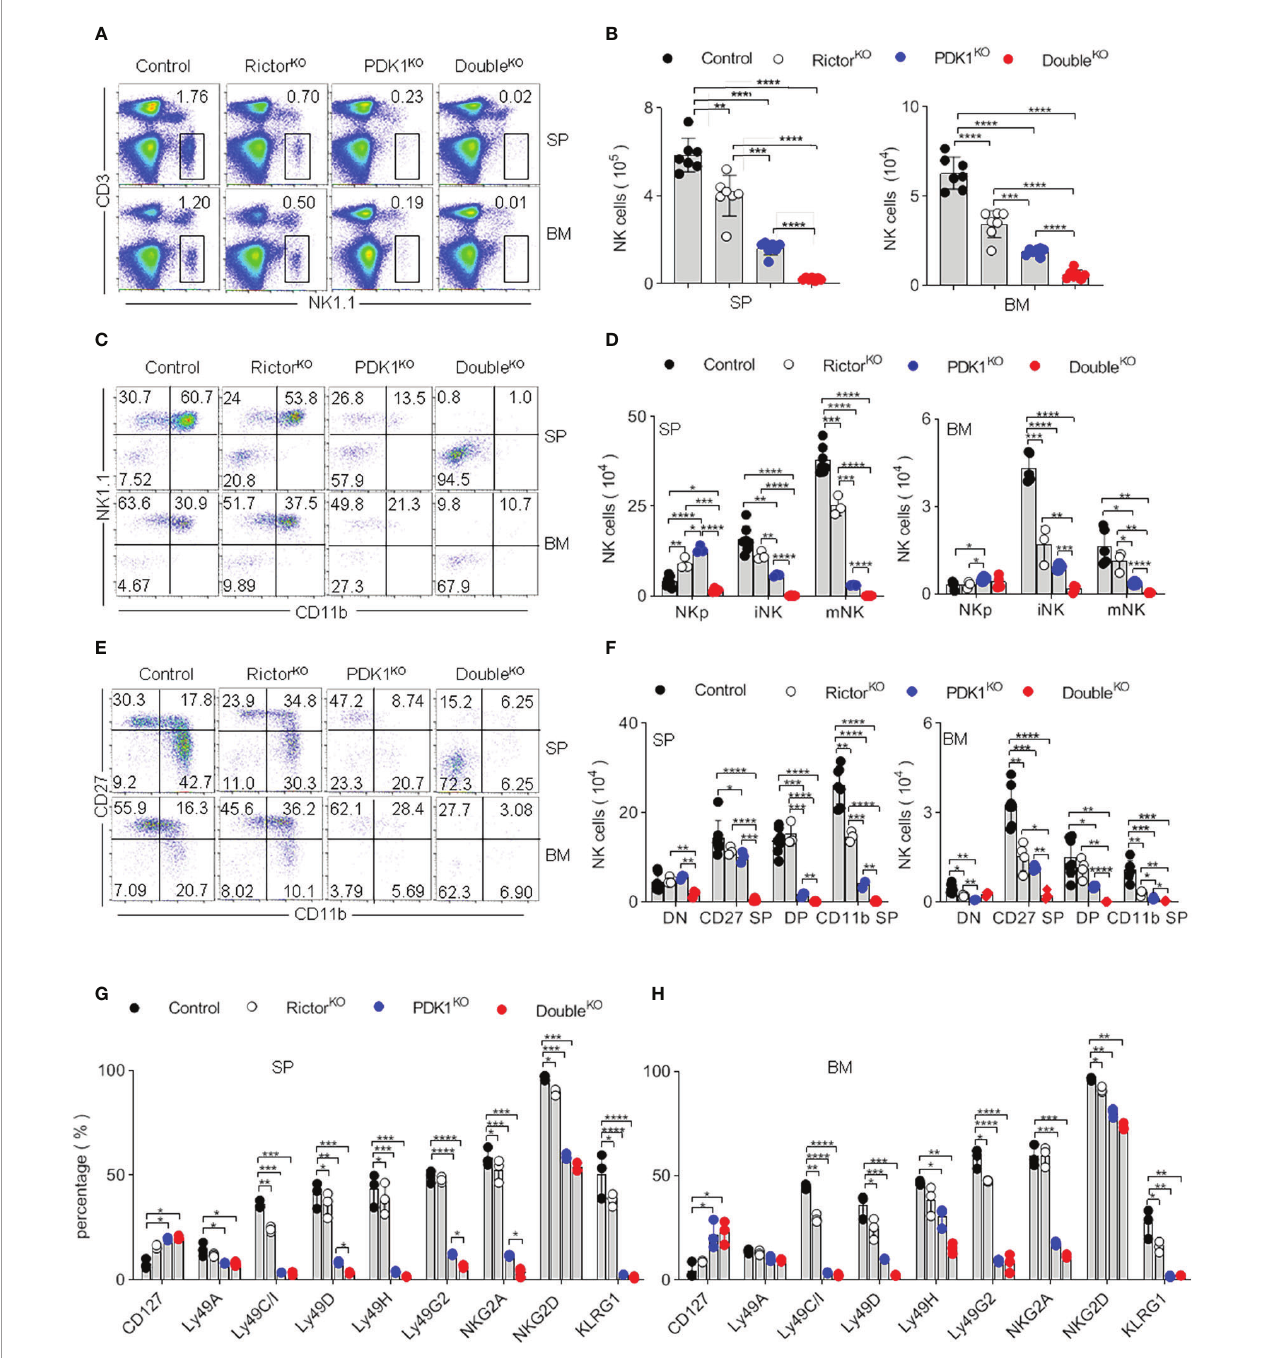
FIGURE 3 | mTORC2 de fi ciency aggravates the developmental defect of PDK1-de fi cient NK cells. (A, B) Representative fl ow cytometric plots (A) and the absolute number (B) of NK cell (CD3 - NK1.1 + ) in the SP and BM of the indicated mice. (C, D) Representative fl ow cytometric plots (C) and the number (D) of NK cell subsets in the SP and BM of annotated mice. NKp (CD122 + NK1.1 - CD11b - ), iNK (CD122 + NK1.1 + CD11b - ), mNK (CD122 + NK1.1 + CD11b + ). (E, F) Representative fl ow cytometric plots of CD27 and CD11b expression (E) and number of stage-speci fi c NK cell (F) in the SP and BM of annotated mice. DN (CD27 - CD11b - ), CD27 SP (CD27 + CD11b - ), DP (CD27 + CD11b + ) and CD11b SP (CD27 - CD11b + ). (G, H) Statistical results of percentage in NK cell membrane receptor expression spectra in SP (G) and BM (H) of indicated mice. The data represent one of three independent experiments, n ≥ 3 for each experiment, and values are expressed as the mean ± SD. *p < 0.05, **p < 0.01, ***p < 0.001, ****p <